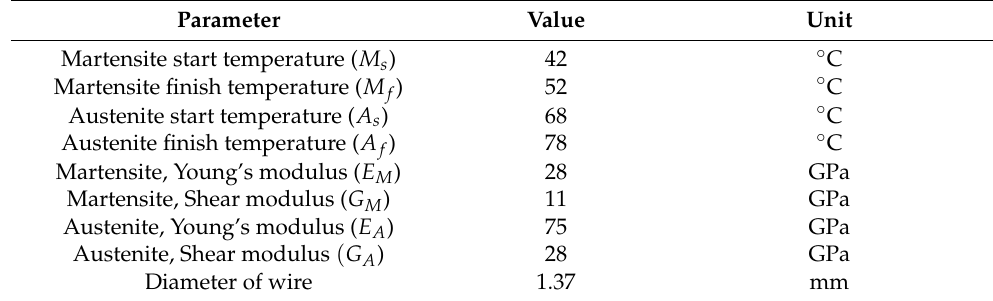
Table 2. Material Properties of SMA.